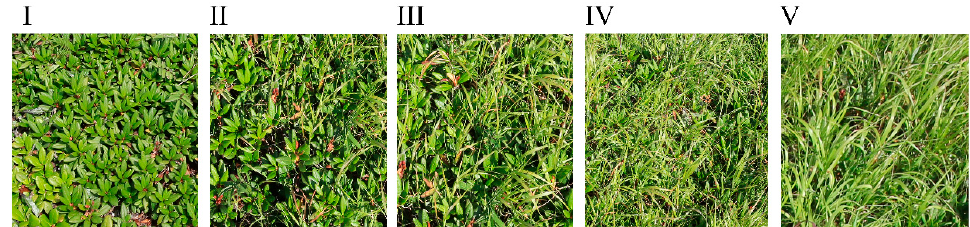
Figure 3. Pictures of Rhododendron aureum communities under five Deyeuxia angustifolia encroachment levels: no encroachment ( I ) had a cover of D. angustifolia of 0%, low encroachment ( II ) had a cover of D. angustifolia between 0 and 30%, medium encroachment ( III ) had a cover of D. angustifolia between 30 and 70%, high encroachment ( IV ) had a cover of D. angustifolia between 70 and 100%, and complete encroachment ( V ) had a cover of D. angustifolia of 100%.